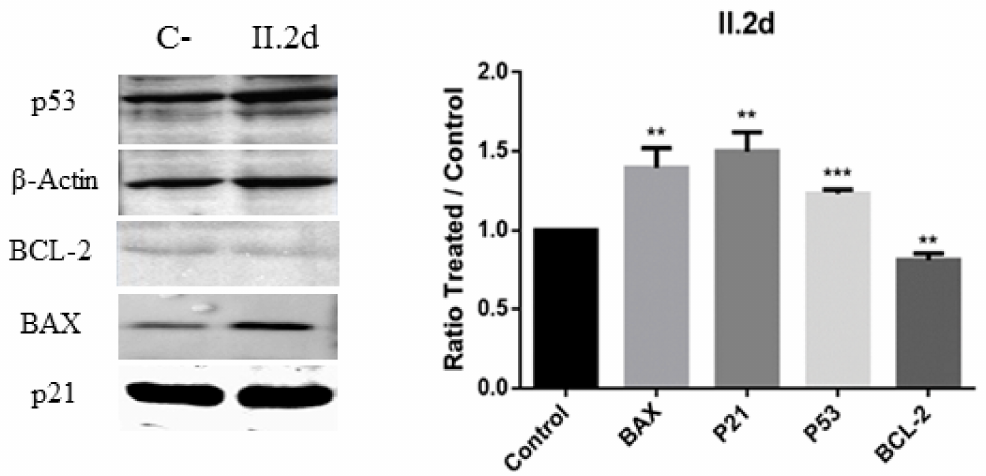
Figure 12. Western blot analysis of apoptosis markers BAX, p21, p53 and Bcl-2 in MCF-7 cell culture treated with II.2d. ** statistical significance with values of p < 0.01; *** statistical significance with values of p <